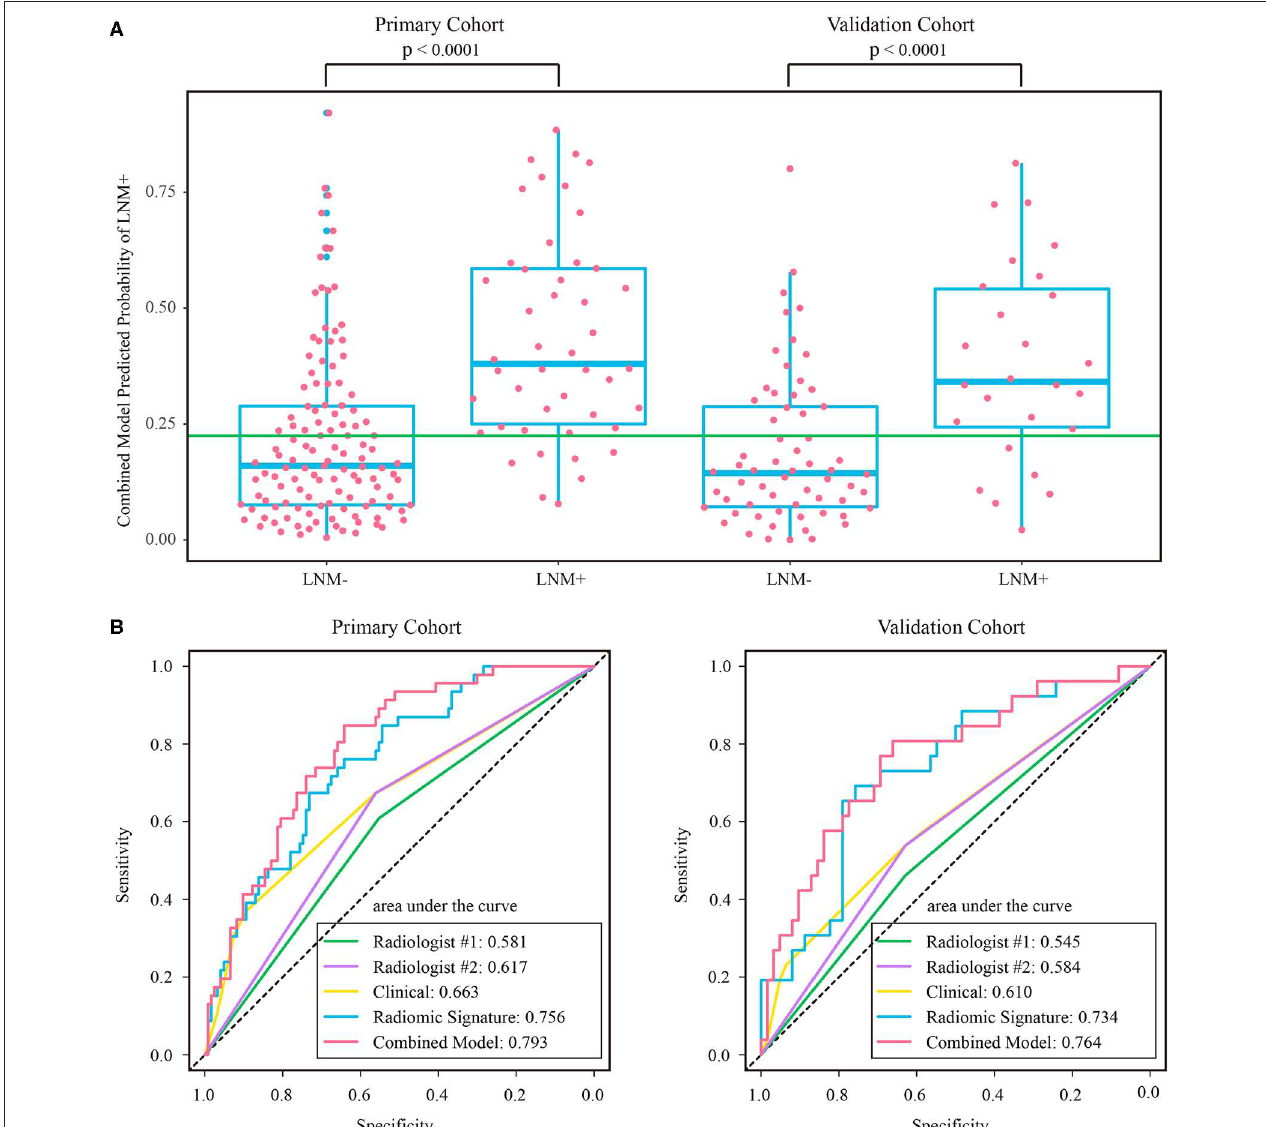
FIGURE 6 | (A) Distribution of combined model predicted probability of LNM + in post-therapeutic ymrT3-4 subgroups of both cohorts, where the green line indicates the Youden cutoff in the primary cohort. (B) ROC curves of radiologists and prediction models in post-therapeutic ymrT3-4 subgroups of both cohorts. LNM + , lymph node metastasis; LNM–, lymph node non-metastasis; ROC, receiver operating